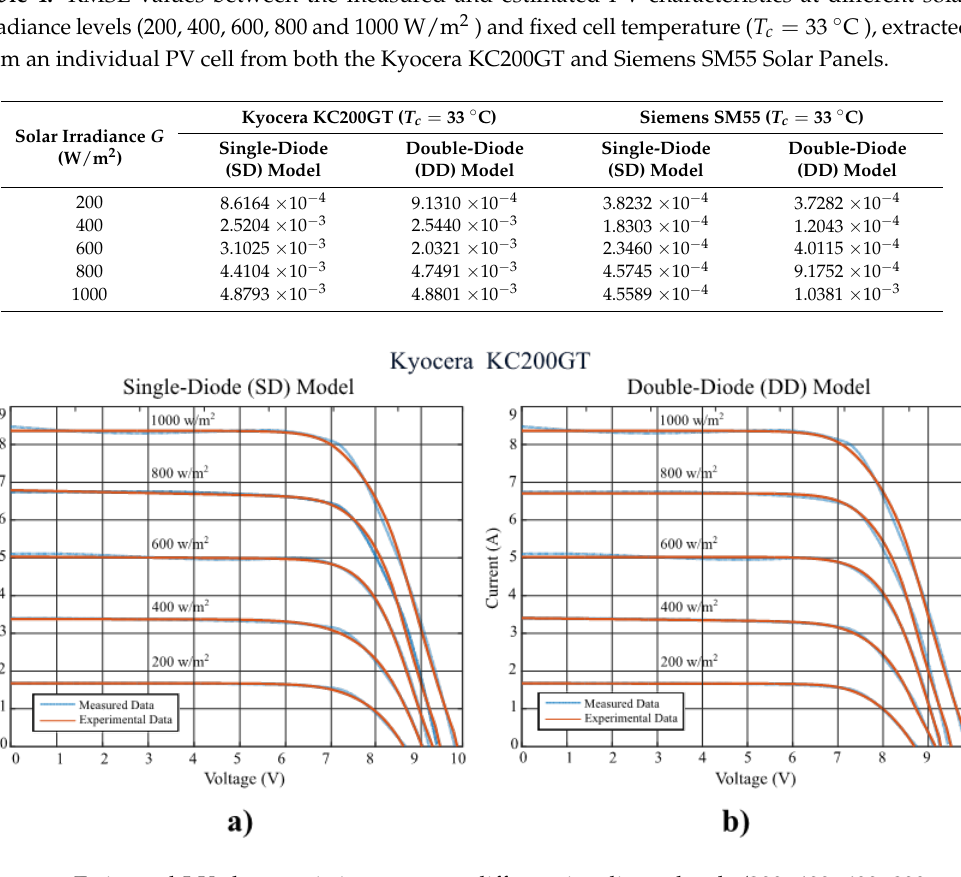
Figure 6. Estimated I-V characteristics curves at different irradiance levels (200, 400, 600, 800 and 1000 W/m 2 ) and fixed cell temperature ( T c = 33 ◦ C ) for an individual cell from a Kyocera KC200GT Solar Panel. ( a ) SD model and ( b ) DD